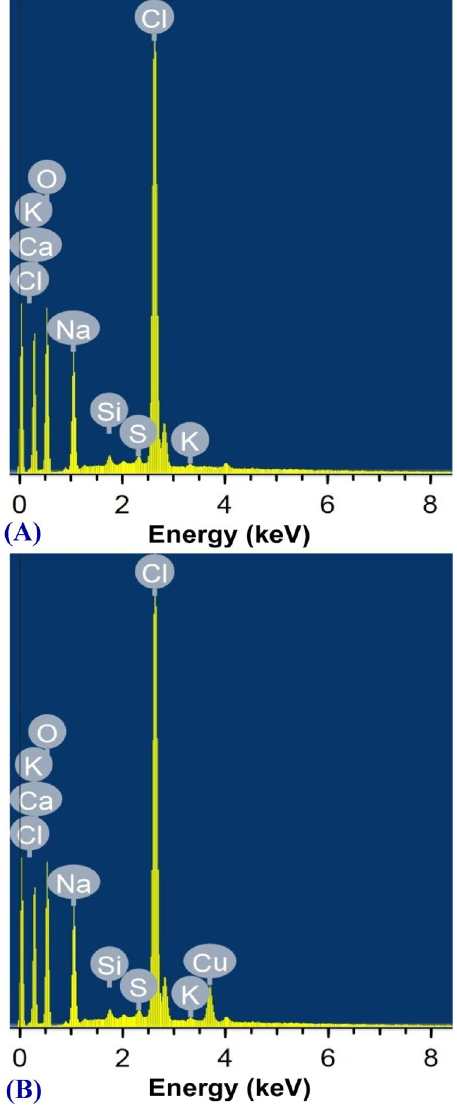
Figure 8. EDS analysis of Azotobacter nigricans NEWG-1 cells: ( A ) before and ( B ) after biosorption of Cu 2 + ions from aqueous